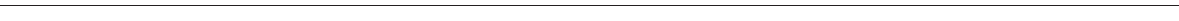
FIGURE 7 | Zeb1 ChIP-seq bound peaks by annotations tool GREAT showing the genomic locations of Zeb1 bound regulatory regions with respect to gene transcription start sites (TSS). (C) List of top de-novo motifs significantly enriched at the Zeb1 bound peaks in unstimulated DCs and their annotated TFs. Zeb1 motif was found to be the top highly enriched motif. (D) SeqMINER clustering demonstrating the overlap of Zeb1 bound peaks in unstimulated CD8 α + cDC1 with PU.1 bound genomic regions in similar condition. The peaks were also overlapped with IRF4 ChIP-seq publicly available data of control and LPS stimulated primary BMDCs. (E) Heat-map demonstrating the immune response pathway genes that were differentially regulated after Zeb1 KD 0, 6, and 12h after CpG activation as compared to control cells. The ChIP-seq binding was also overlapped to identify if Zeb1 directly regulates immune response genes. All the immune response genes that were differentially regulated ( > 2-fold up or down-regulated) are listed. The genes that were reported and are important in Th cell polarization through DCs are highlighted in bold. To generate this bar-graph Z-score was calculated for each gene from normalized FPKM values to demonstrate the differential regulation of genes in control and Zeb1 KD DCs at 0, 6, and 12h after CpG activation. (F) Bar-plot depicting the differential regulated genes in Zeb1 KD DCs at 0, 6, and 12h after CpG activation. The genes were classification into two different groups based on GO annotation i.e., immune response genes (immune) and other pathway genes (others). It was observed that in immune response gene group there is preferential upregulation of genes after Zeb1 KD whereas in the other group there was higher number of upregulated genes ( > 1.6- to 2.5-fold) compared to down-regulated ones. (G) Bar-plot showing the IPA pathways significantly enriched for the genes that were directly bound and regulated by Zeb1 at 12h after CpG activation.